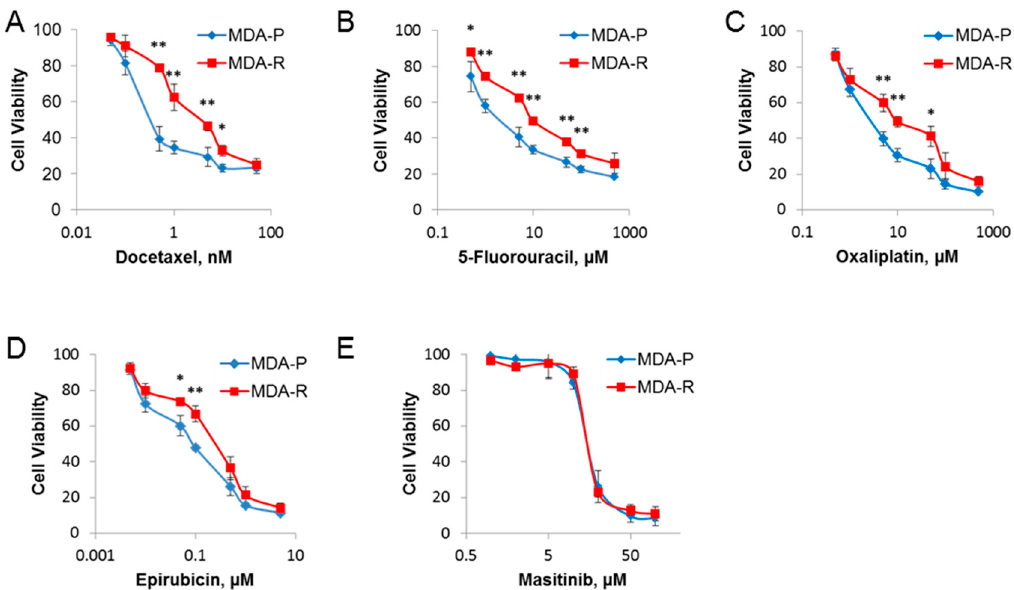
Figure 7. RH1 resistant cells acquire insusceptibility to conventional chemotherapy drugs, but not to c-KIT-targeted therapy. MDA-P and MDA-R cells were treated with increasing concentrations of drugs for 48 h: ( A ) docetaxel; ( B ) 5-fluorouracil; ( C ) oxaliplatin; ( D ) epirubicin; or for 72 h for ( E ) masitinib. Cell viability was measured after 96 h using the MTT assay. The results are the mean of 3 independent experiments; bars are ± SD (ANOVA; * p < 0.05; ** p < 0.01).